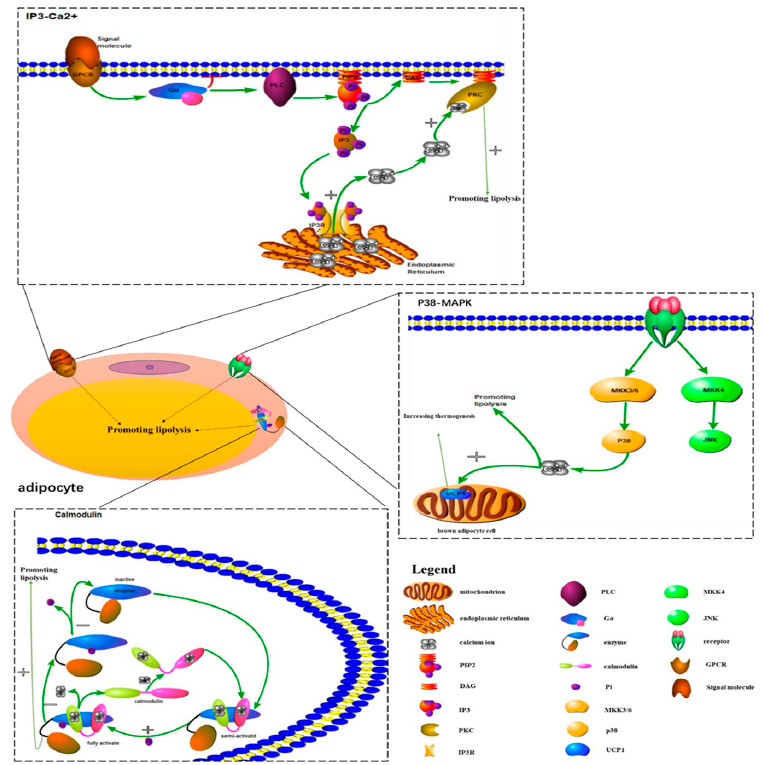
Figure 1. Signal transduction mechanisms of the main calcium signaling pathways related to obesity in adipocytes.